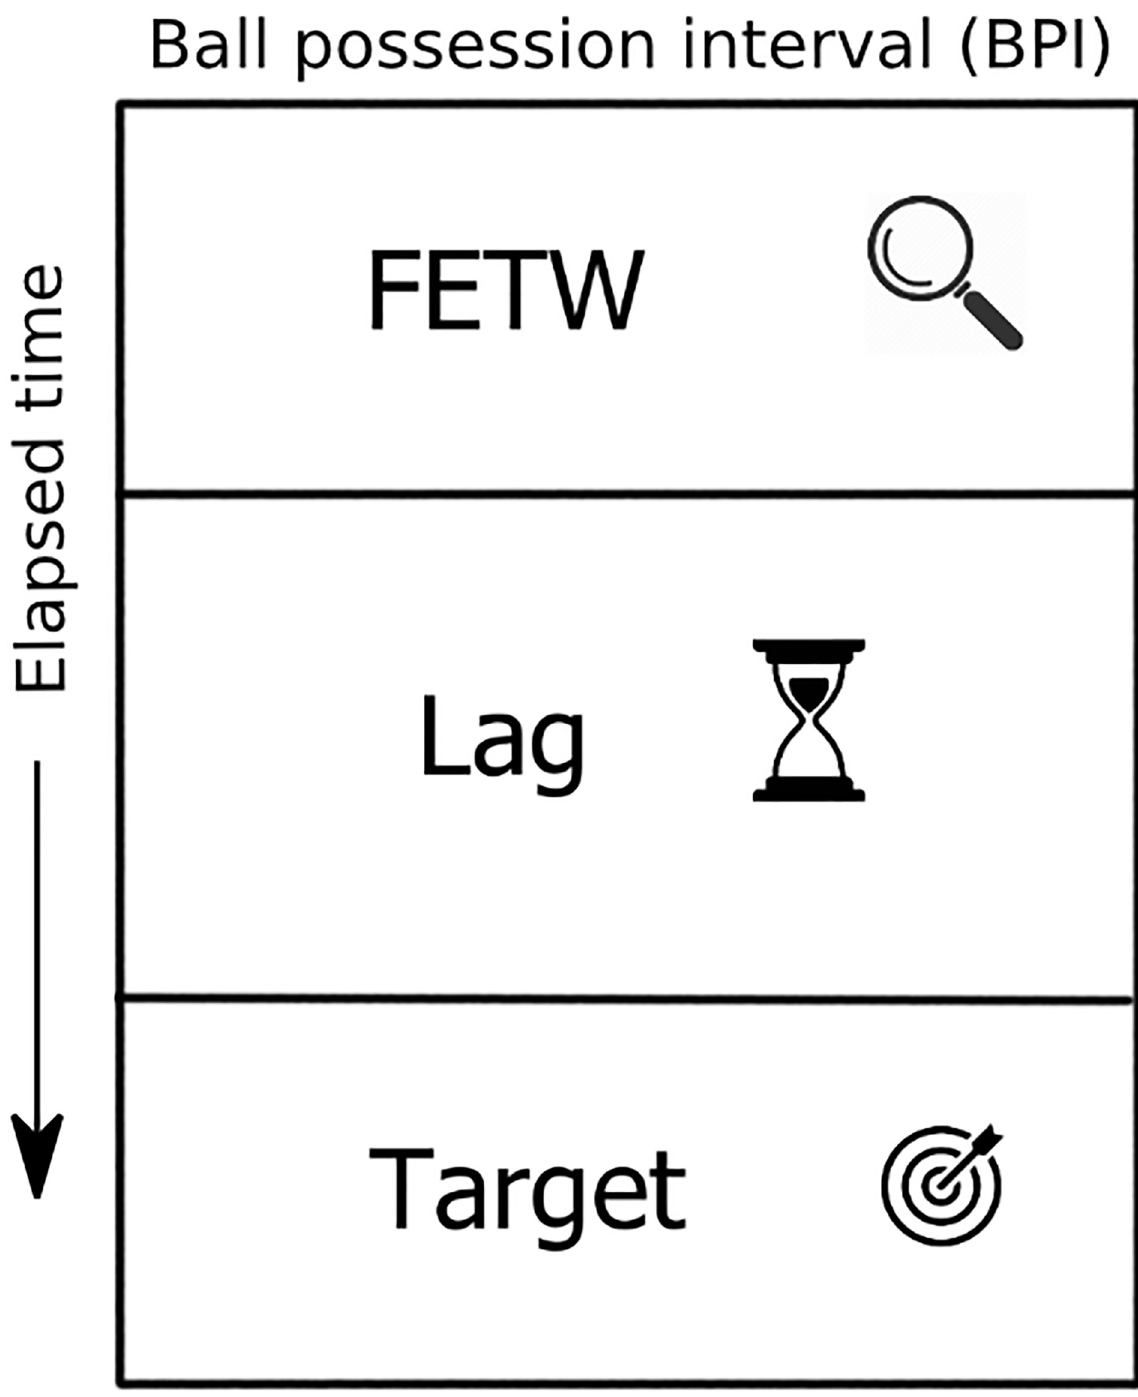
Fig 2. Division of BPI possession